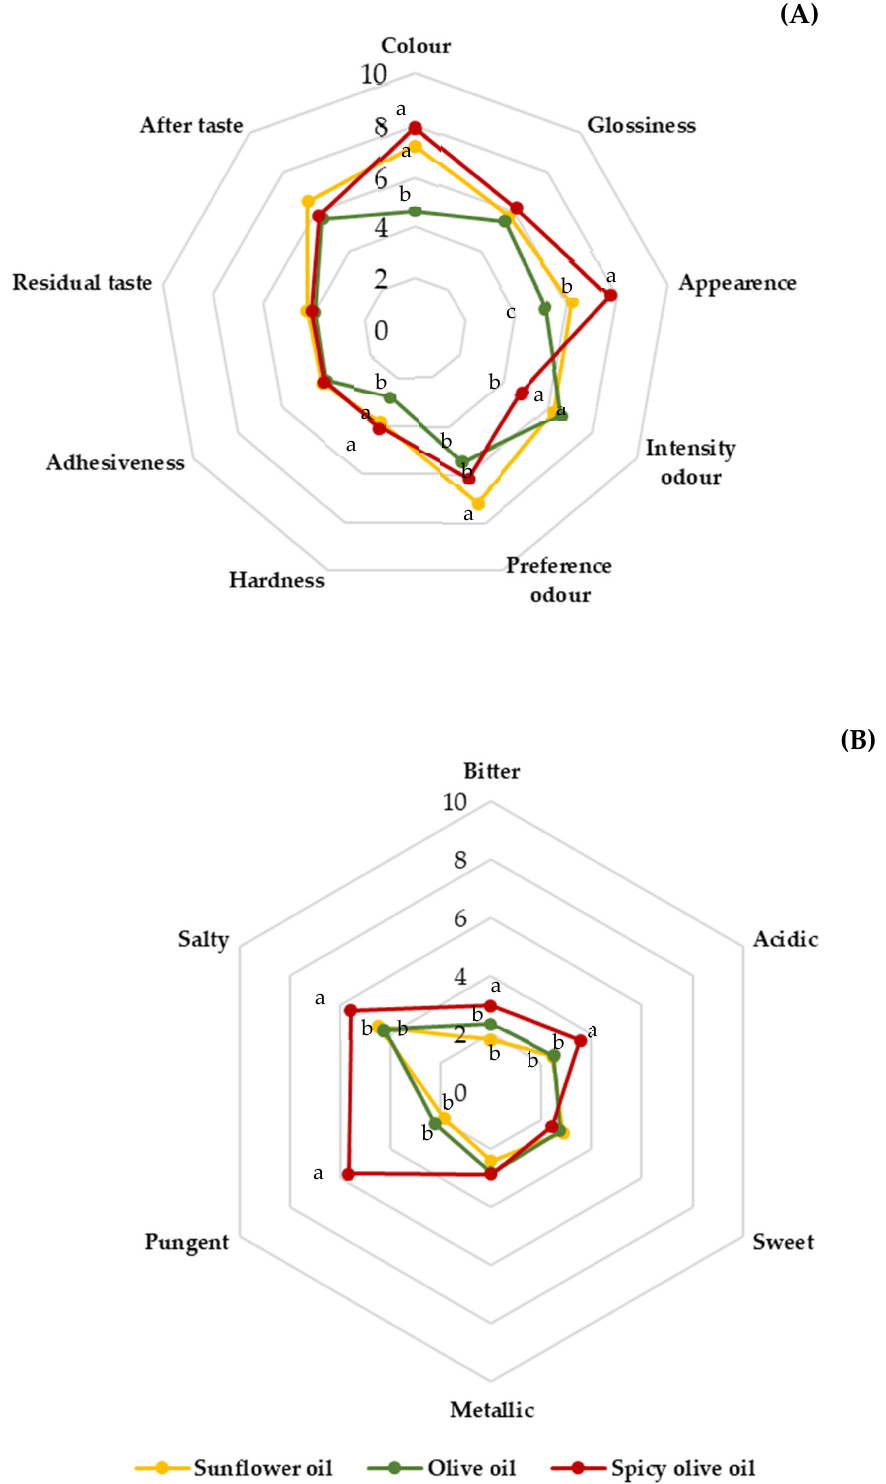
Figure 5. Graphic expression of the sensory profiles of canned eel packed with different filling media. ( A ): texture in mouth and aroma; ( B ): taste. Plotted values are the means of 11 observations. Different letters indicate significantly different ( p < 0.05).